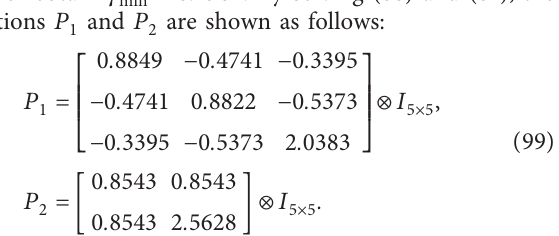
Figure 8: Comparison of real disturbance d